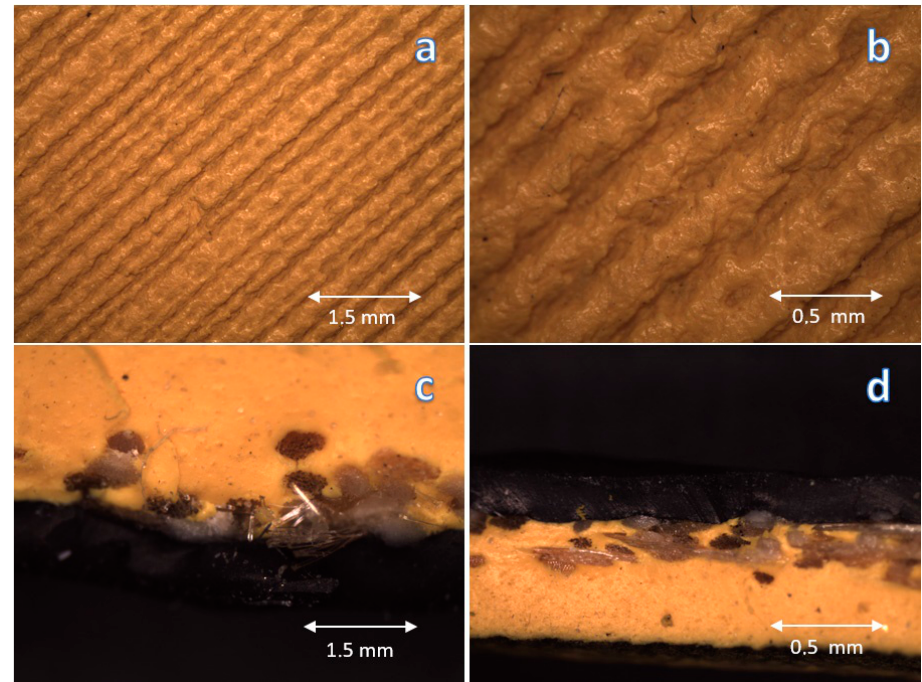
Figure 5. Photos of Kap 7 ball: surface ( a ) 10×, ( b ) 30×, cross-section photos ( c ) 10×, ( d ) 30×.